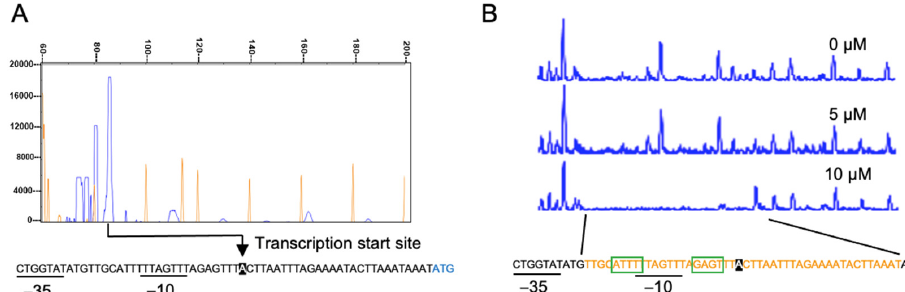
Figure 3. Characterization of the ygaVP promoter: ( A ) Primer extension analysis of the ygaVP promoter. Signal of the reverse transcripts and size markers are blue and red, respectively. (( A ), bottom) The RNA polymerase σ -subunit recognition site ( − 10 and − 35) and the translational start site of YgaV (blue) are shown. Reverse transcription was conducted with purified RNA and the fluorescent–labeled primer. The synthesized cDNA was mixed with the 600 LIZ Size Standard (Applied biosystem), and then analyzed using a 3730xl DNA analyzer (Applied biosystems). Finally, fragment analysis was conducted with Peak scanner software v.1.0 (Applied biosystem); ( B ) DNase I footprint analysis of YgaV. Binding to the ygaVP promoter DNA with different concentrations of reduced YgaV. Regions corresponding to the DNase I protection regions are shown in red. Mo- tifs similar to the putative Rc SqrR-recognition sequences are indicated by green boxes (for details, see